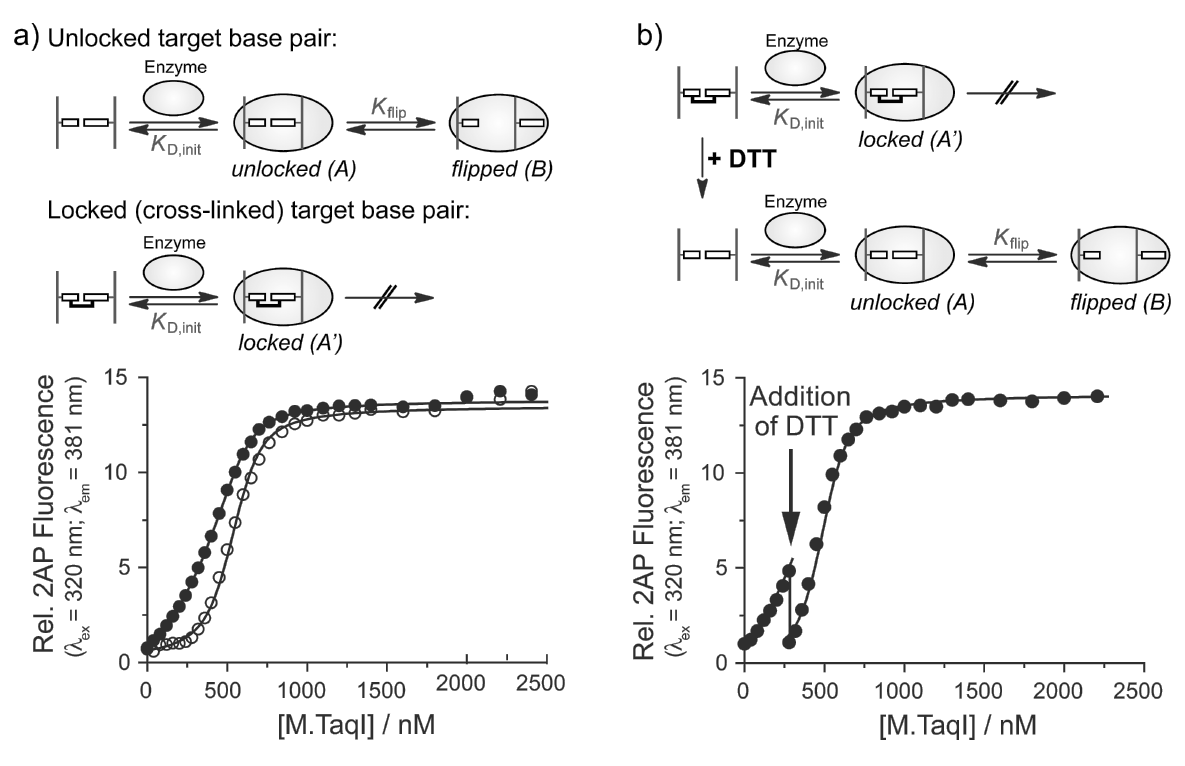
Figure 6: Competition binding of M.TaqI to DNA with unlocked and locked target base pairs. Increasing amounts of M.TaqI were added to a mixture of the DNA of interest and a fluorescent DNA with known K D that contains the target base analog 2-aminopurine (2AP). A more delayed increase in the 2AP fluorescence indicates tighter binding of the non-fluorescent DNA. (a) Binding of M.TaqI to duplex 1 I6S ∙ 2 U4S with unlocked target base pair (top reaction scheme and open circles) allows base flipping of the target base into the active site. The observed dissociation constant comprises both the initial binding constant K D,init and the base flipping equilibrium constant K flip . Binding of M.TaqI to the cross-linked duplex 1 I6S-Et-S4U 2 with locked target base pair (bottom reaction scheme and closed circles) prevents base flipping, and the observed dissociation constant equals K D,init . (b) Switching from locked to unlocked target base pair during the M.TaqI binding experiment. The same competition titration was started with the cross-linked duplex 1 I6S-Et-S4U 2 in buffer without reducing agent preventing base flipping. Upon addition of DTT (arrow) the cross-link is unlocked enabling base flipping and thus tighter binding. The titration is continued and now follows the binding curve for the duplex with unlocked target base